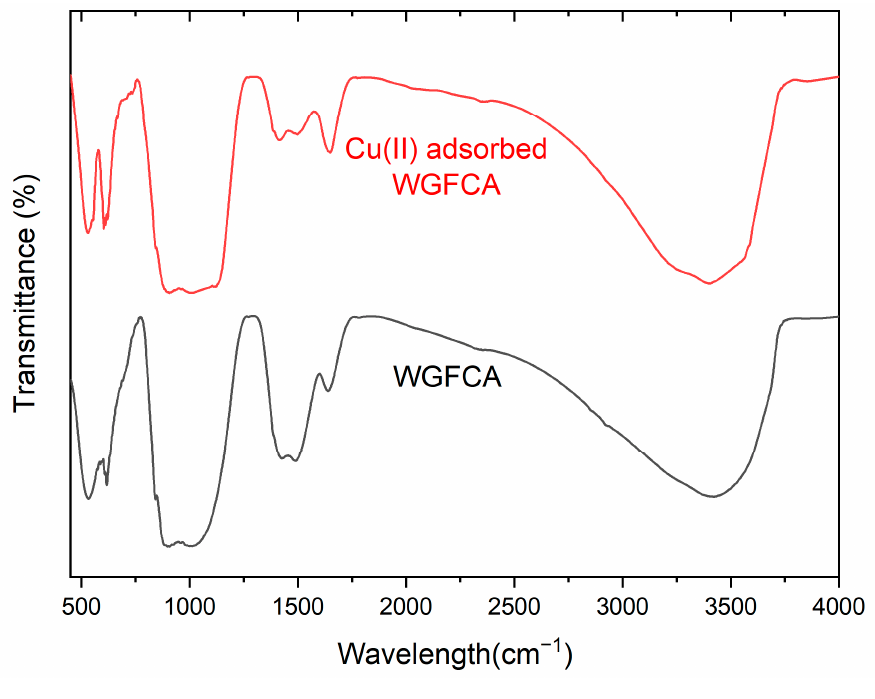
Figure 5. FT-IR spectra of WGFCA before and after Cu adsorption.